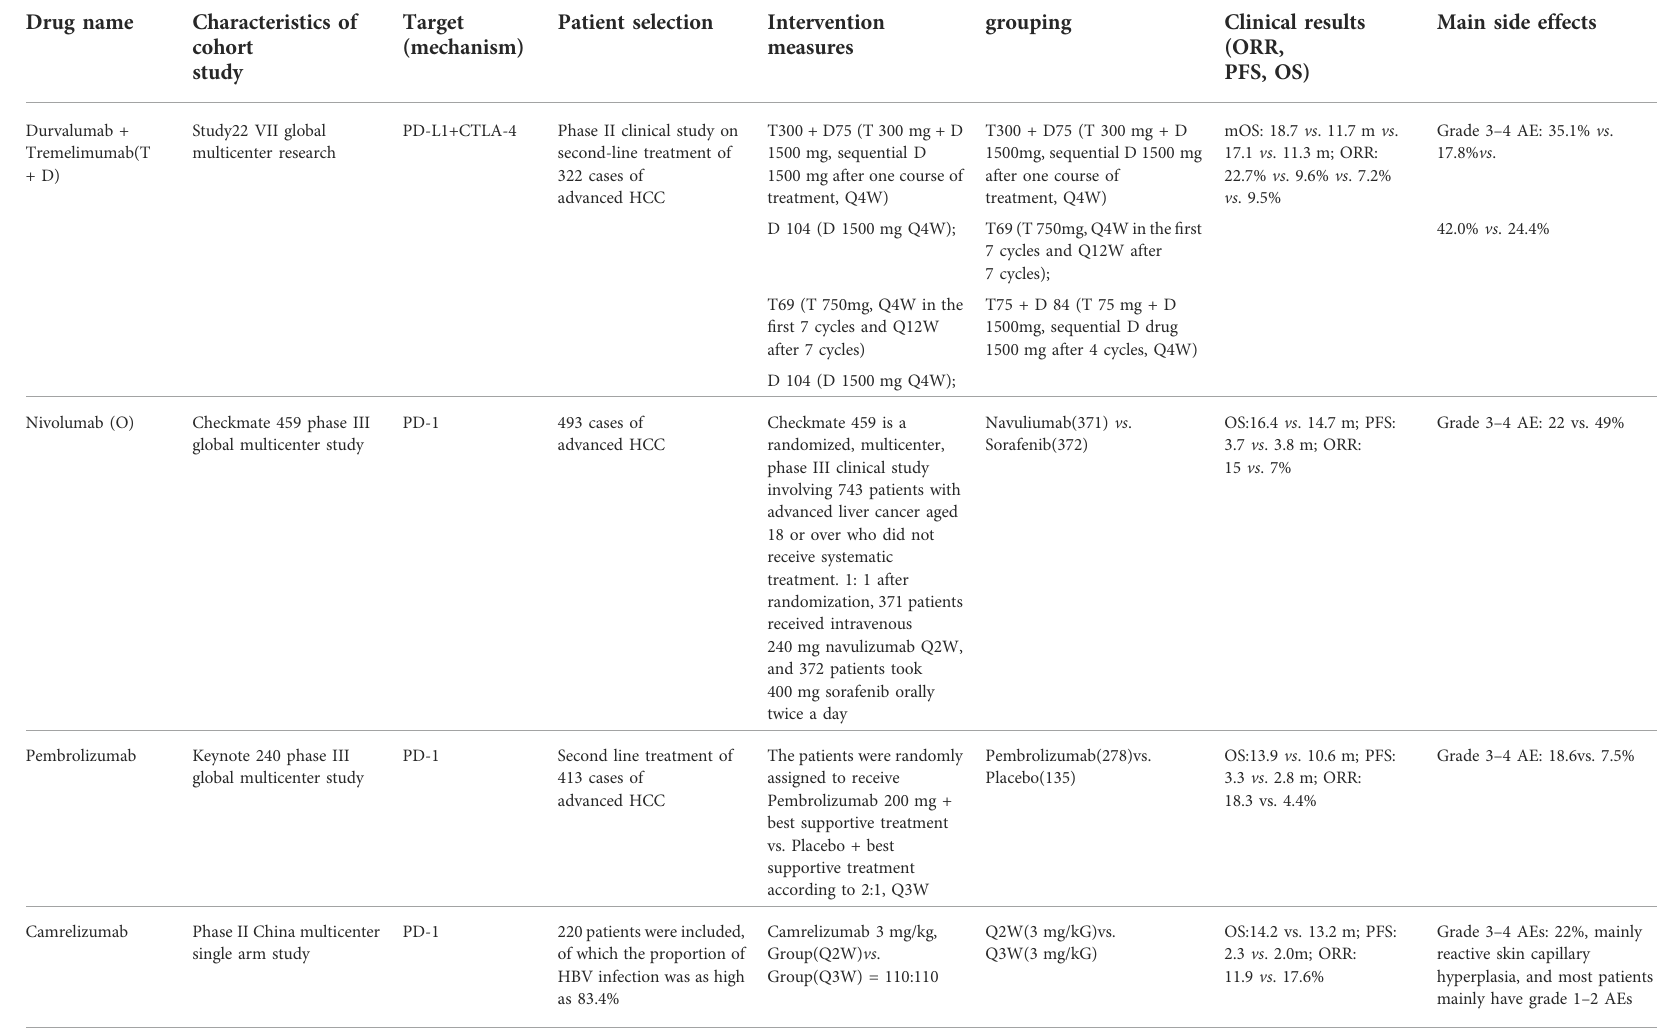
TABLE 1 ( Continued ) Progress of various immune checkpoint inhibitors in the treatment of primary liver